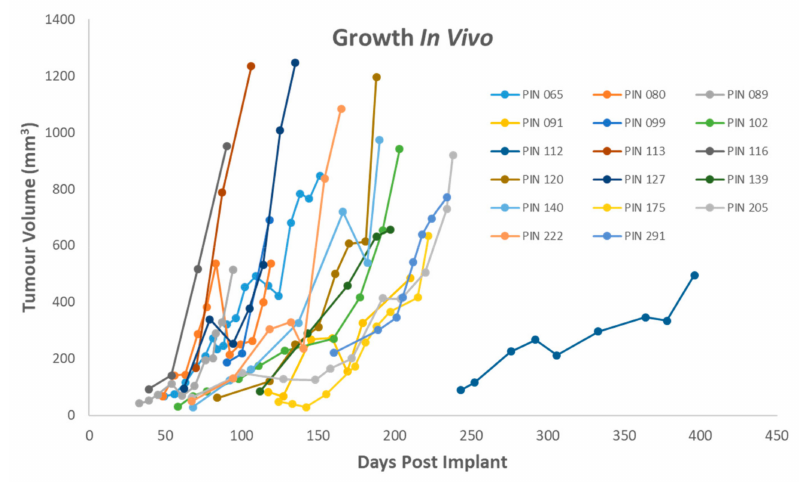
Figure 1. Tumour growth in vivo of patient derived xenograft (PDX) samples. PIN 099, 112, 139, 175, 190, 222, 291 represent single animals while the remainder represent an average growth